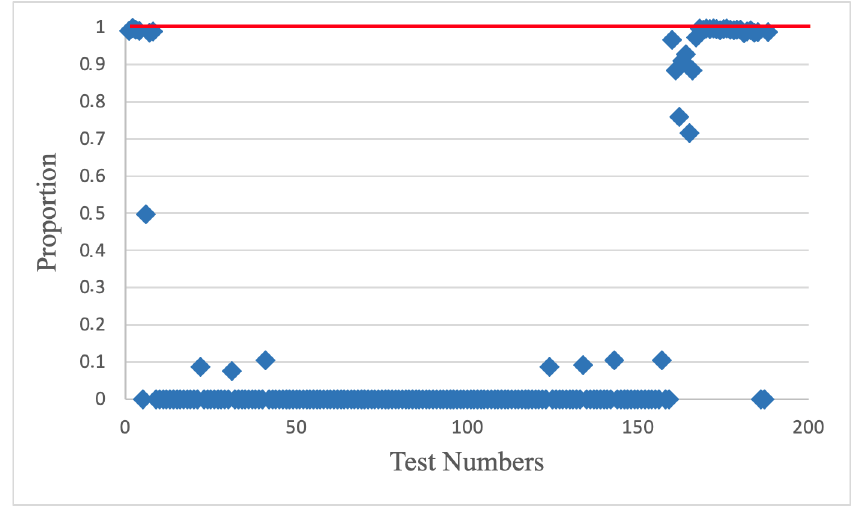
Figure 3. Statistical portrait of AFG at m =